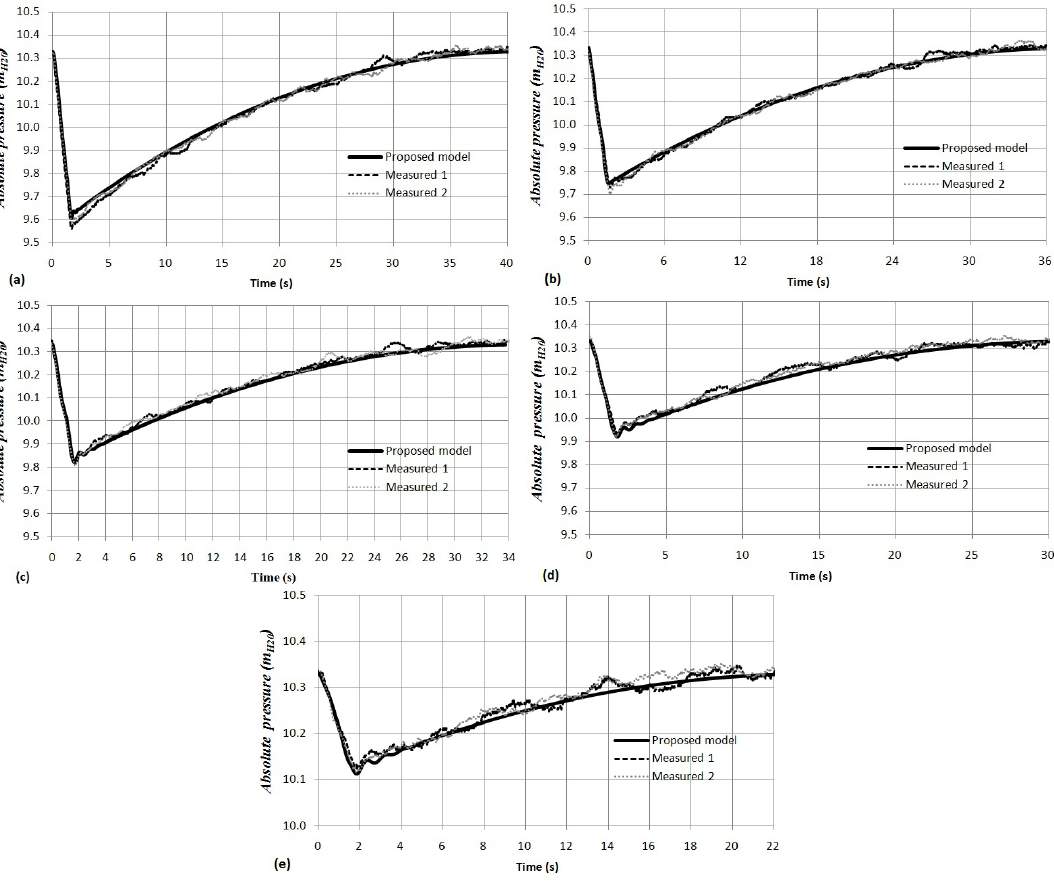
Figure 5. Comparison between computed and measured absolute pressure oscillation patterns (air valve S050): ( a ) Test No. 1; ( b ) Test No. 2; ( c ) Test No. 3; ( d ) Test No. 4; ( e ) Test No.